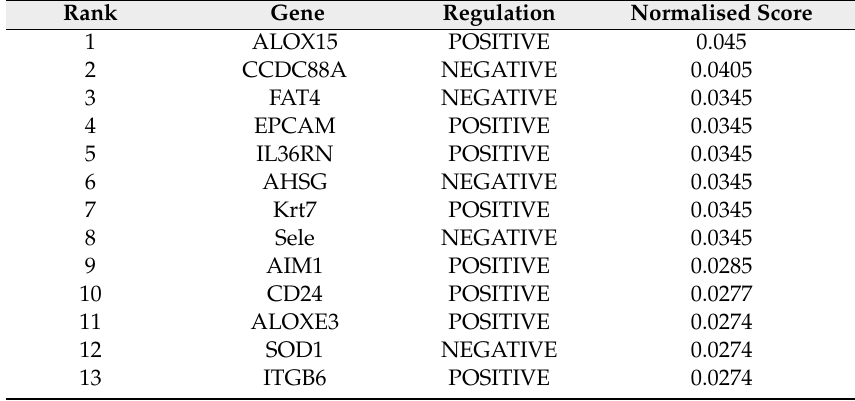
Table 6. The top 50 most di ff erentially regulated genes in cancer cell lines following modulation of grh / Grhl